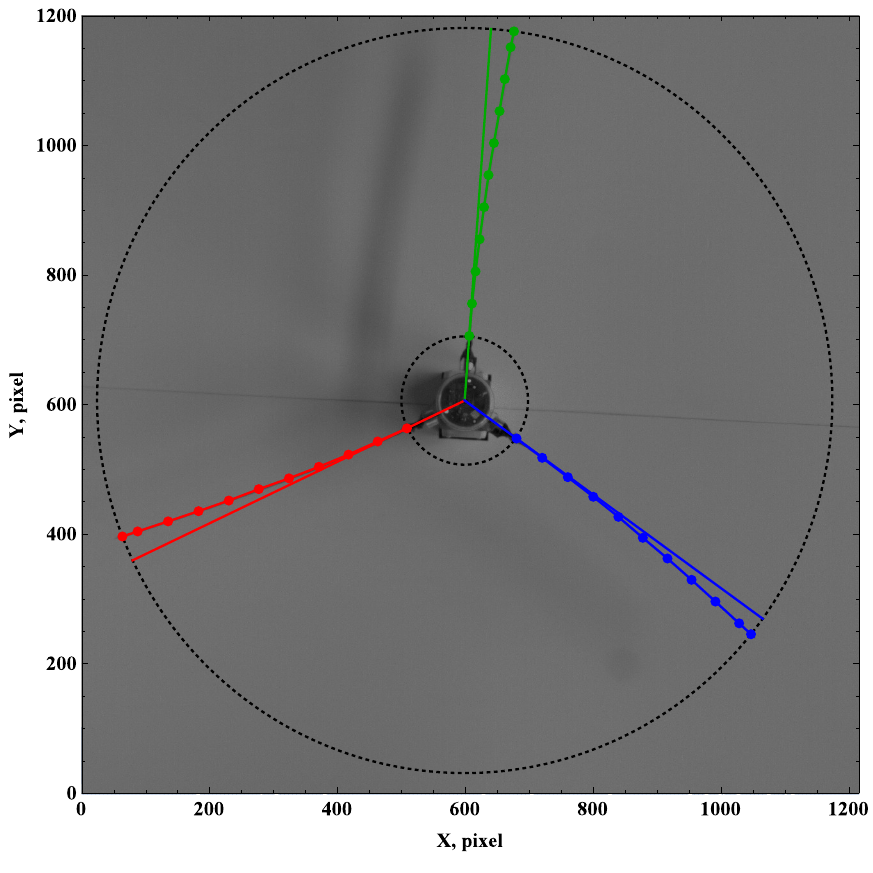
Figure 12. Preset angle 90 ◦ , angular speed 50 rpm: top view; side view is not